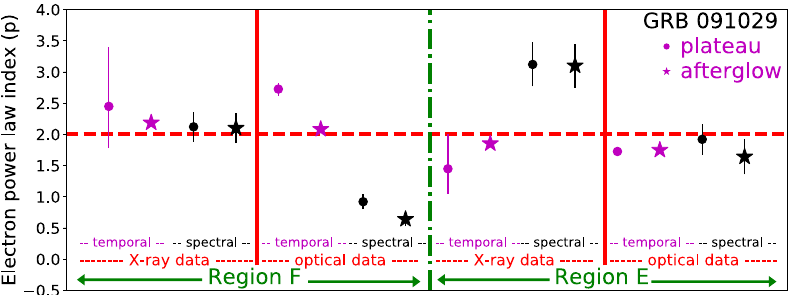
Fig. 2 | An example demonstrating howwedetermine the relevant regionfor a given source as well as the electron power-law index ( p ) shown in Table 1. For eachburst(inthecasespresentedhere,GRB091029),weconsidereightindependent indicators,namelythe temporal(purple)andspectral(black)slopesof boththe X-ray and optical data during both the plateau (dot) and self-similar (star) phases. These